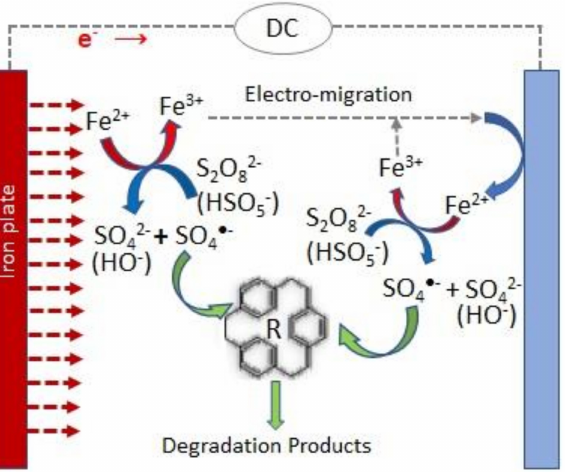
Figure 2. Scheme of the main reactions involved in the persulfate electrochemical activation when sacrificial iron anodes are